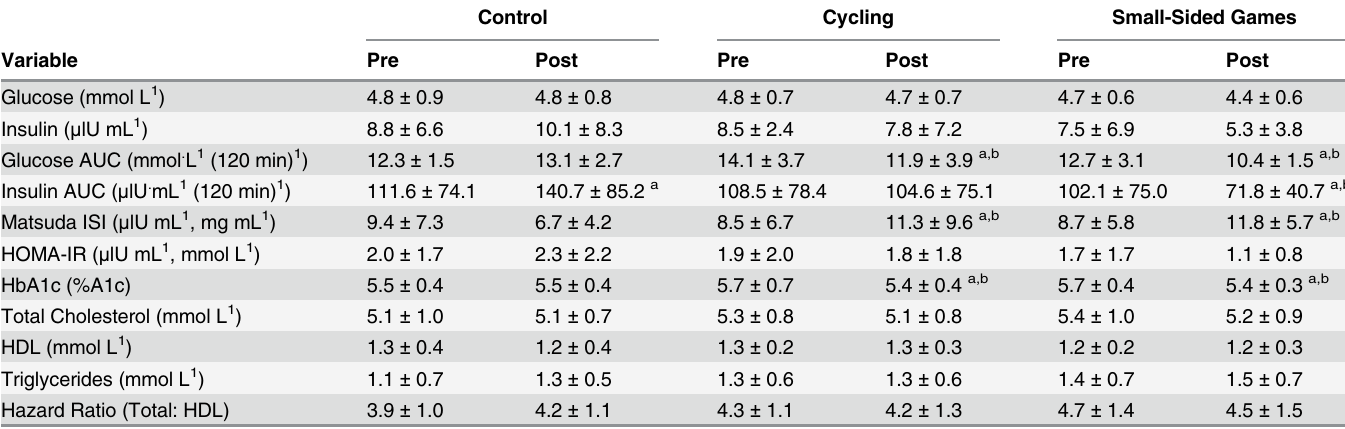
Table 3. Mean ± SD fasting blood chemistry and glucose tolerance test pre and post 8 weeks of control (n = 11), continuous cycling (n = 11) or small-sided games (n = 10).